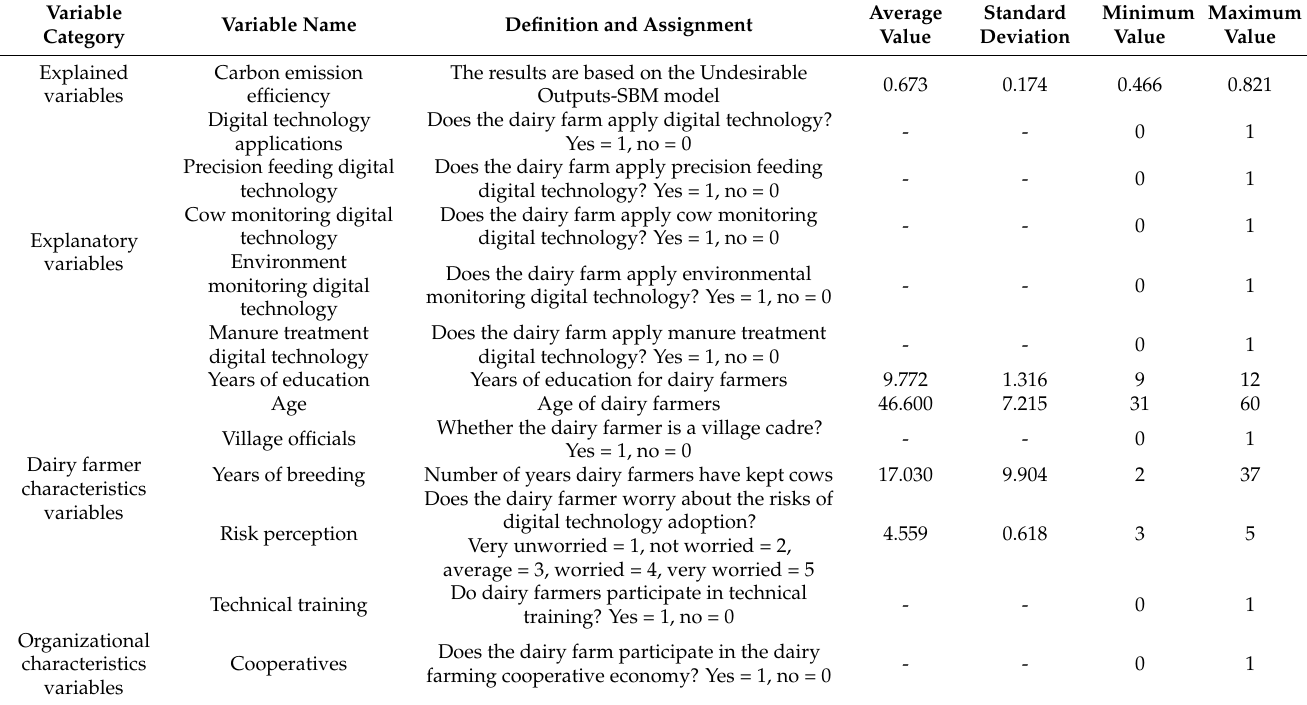
Table 3. The variable descriptions and descriptive